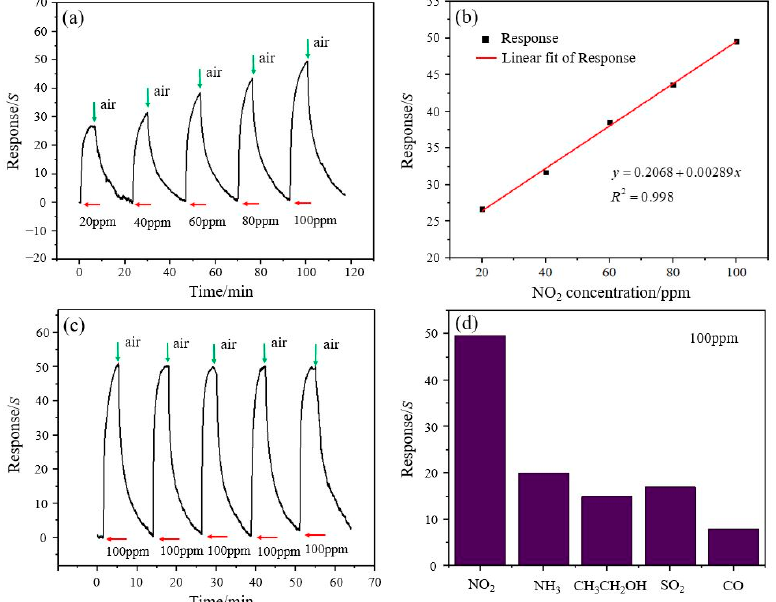
Figure 6. ( a ) The response value change curve of the rGO/ZnO-5 nylon fiber sensor in the NO 2 concentration range of 20–100 ppm, ( b ) the linear fitting curve of the response values, ( c ) the repeatability test curve for 100 ppm NO 2 , and ( d ) the selectivity test results for different gases with a concentration of 100 ppm.